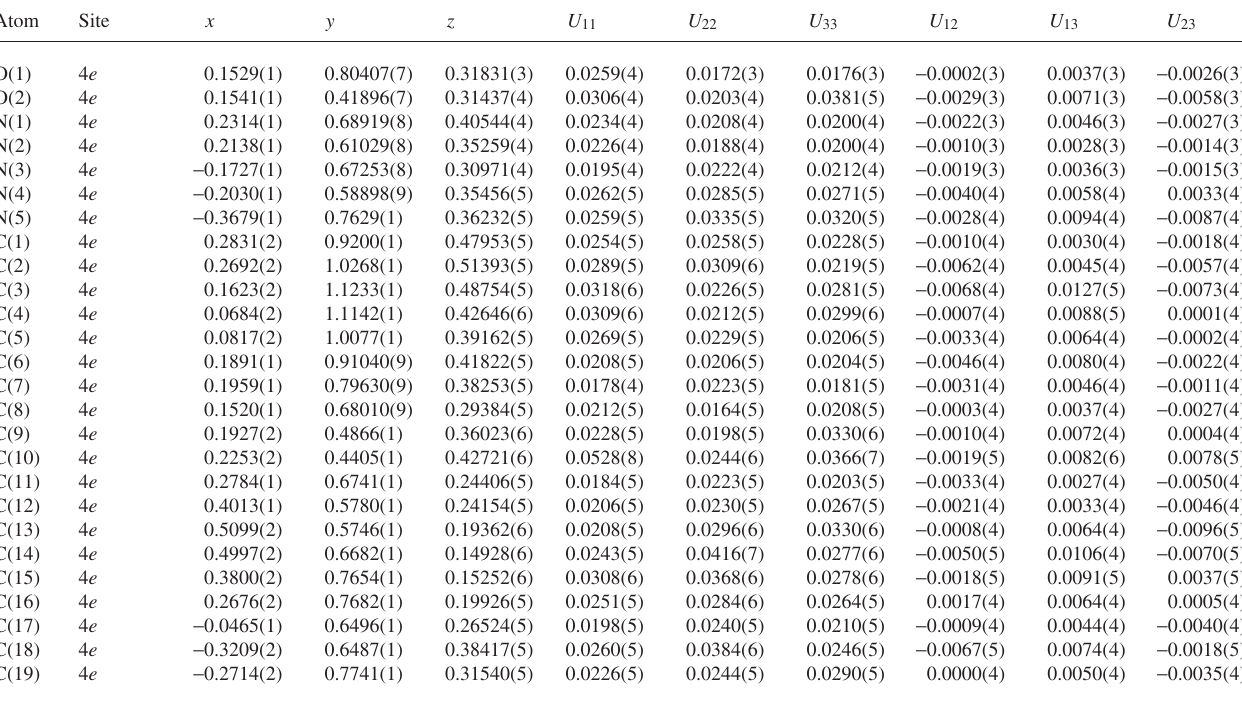
Table 3. Atomic coordinates and displacement parameters (in Å 2 ) .